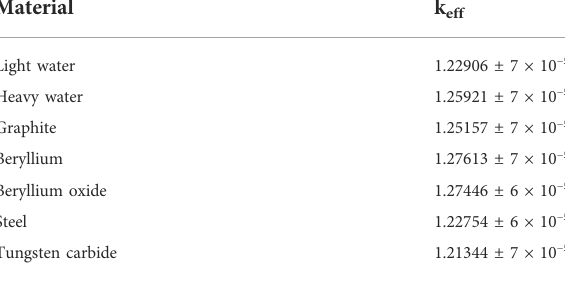
TABLE 3 k eff eigenvalue results of two-batch refuelling scheme core with different material re fl ectors. Material k eff Light